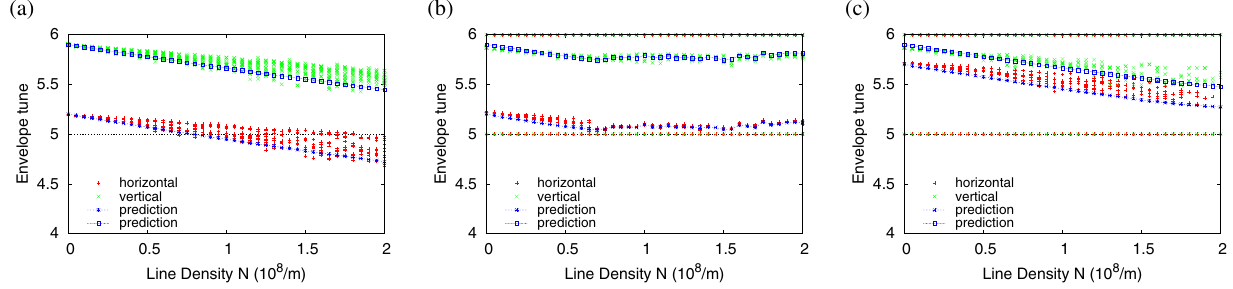
FIG. 3. Top ten peaks of the FFT spectrum of the envelope radius for (a) without quadrupole error ( ν x ¼ 2 . 6 , ν z ¼ 2 . 95 ), (b) with quadrupole errors ( ν x ¼ 2 . 6 , ν z ¼ 2 . 95 ), and (c) with quadrupole errors ( ν x ¼ 2 . 85 , ν z ¼ 2 . 95